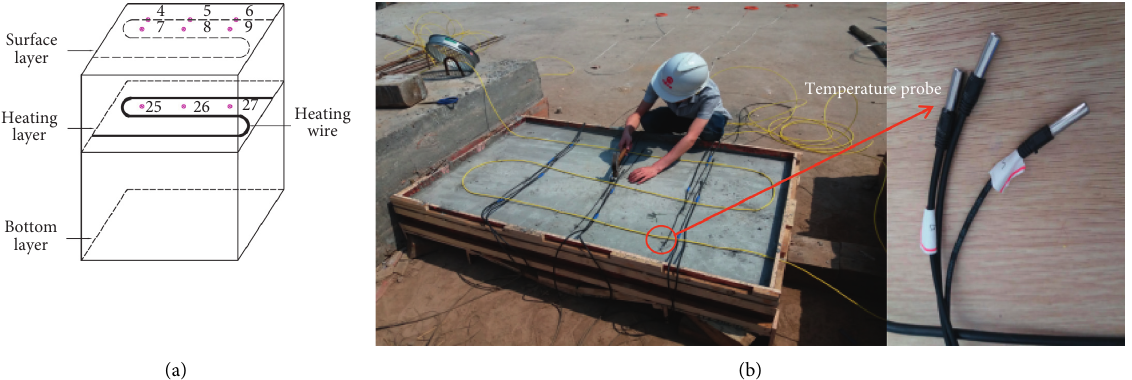
Figure 2: Measuring point layout. (a) The location of the measuring points. (b) Lay the temperature probe.